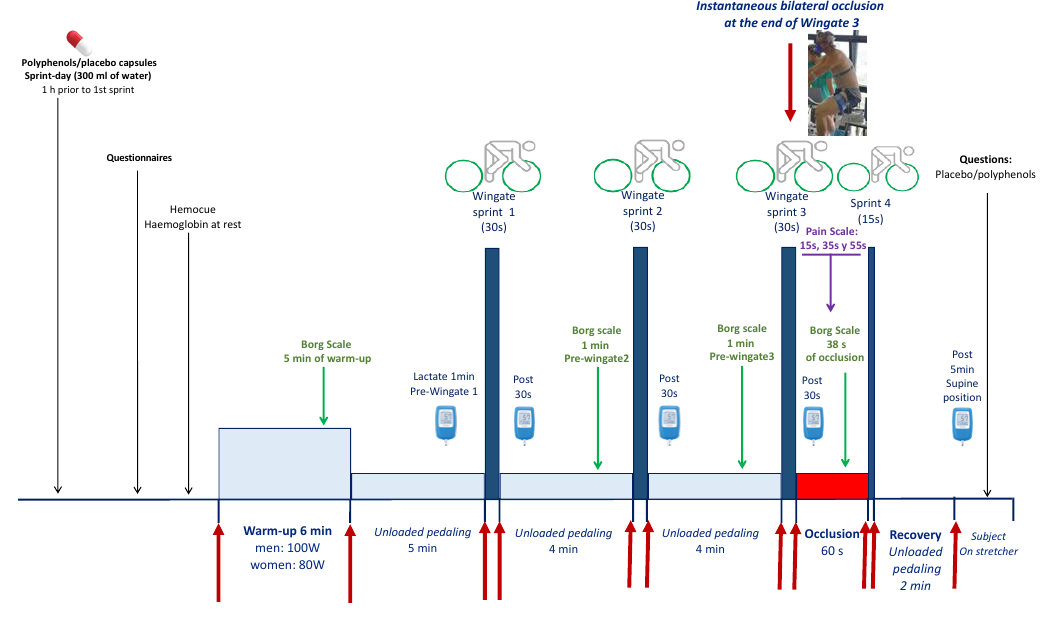
Figure 1. Experimental protocol.